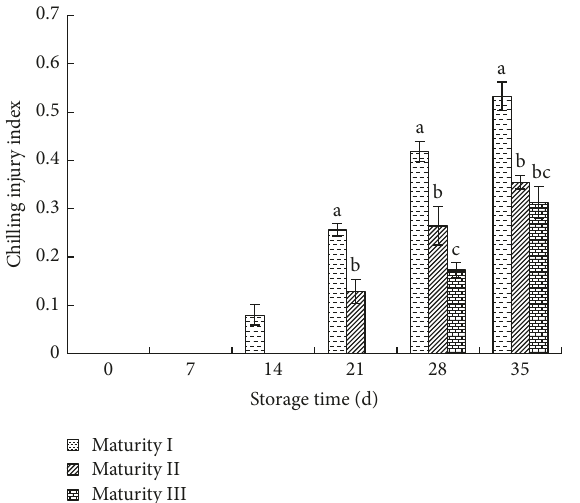
Figure 1: Effects of harvest maturity on chilling injury index in apricots; fruits with maturity class I (colored area < 50%), maturity class II (colored area 50–80%), and maturity class III (colored area > 80%) were categorized according to the yellow conversion rate. Vertical bars represent the standard errors of the means of triplicate replicates. a, b, c = bars at each storage time point have different letters which are significantly different at P < 0.05.